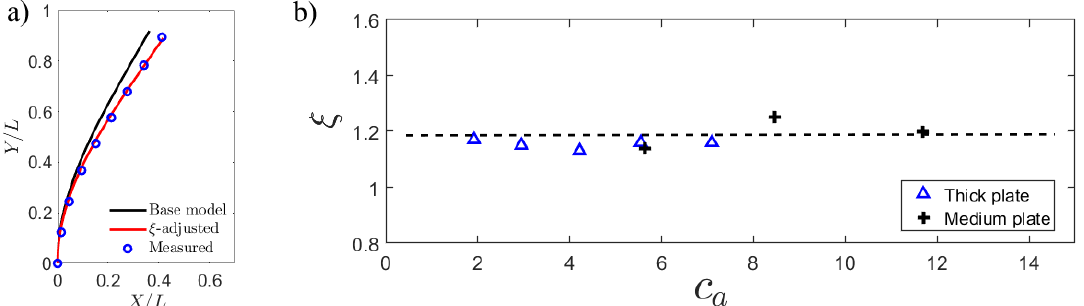
Figure 15. ( a ) Measured and modeled plate bending with and without ξ correction for the medium plate at ω = 60 rpm; and ( b ) correction factor ξ for low and intermediate plate